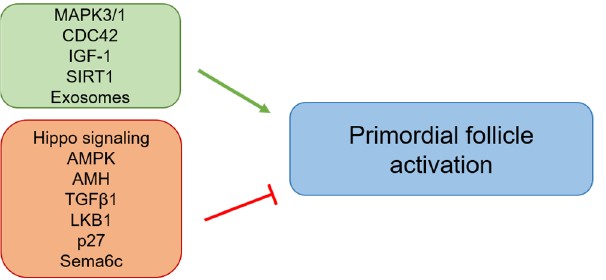
Figure 5. The roles of other pathways and molecules in primordial follicle activation. The green arrow indicates activation of primordial follicles, and the red arrow indicates inhibition of primordial follicle activation.